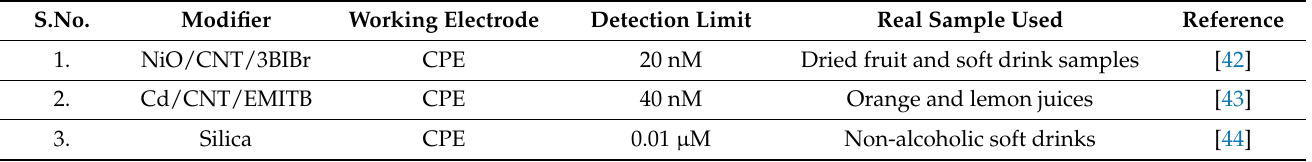
Figure 11. Ball and stick atomic model of Carmosine. In 2017, M. Bijad et al. [42] detected CR at a CPE modified using NiO/CNT with 3-methyl-3-butyl imidazolium bromide (3BIBr) in the presence of TR. They used CV to compare the peak currents of bare and modified electrodes. Modified electrodes showed enhanced peak currents and the electron transfer process was irreversible. The electrode showed a detection limit of 20 nM in the presence of TR. Dried fruit and soft drink samples were employed for the real sample analysis of both the dyes (TR and CR) and gave a recovery >99.25%. In 2018, H. M. Nehzad et al. [43] detected CR at a CPE modified using Cd/CNT& 1-ethyl-3-methylimidazolium tetrafluoroborate (EMITB). They studied the electrochemical behavior of CR at the modified electrode using linear sweep voltammetry (LSV) and found low oxidation current with enhanced peak current. This indicated good electrical conductivity and long-term stability of modified electrodes with a detection limit of 40 nM. The real sample analysis using fruit juices showed a recovery >97% at this electrode. In 2020 the detection of CR was performed by using CPE modified by silica with cetylpyridinium chloride (CPE/SG/CPC), which has high sorption ability compared to azo dye (A. Chebotarev et al. [44]). The authors discussed the electrochemical behavior of CR on the CPE, CPE/SG, and CPE/SG/CPCl, in a detailed manner using SWV (shown in Figure 12) and CV at pH 2. The peak current is higher at CPE/SG/CPCl when compared to other electrodes. The limit of detection for this modified electrode was found to be 0.01 µ M. Their results prove that silica with cetylpyridinium chloride will improve the CR adsorption on the electrode surface. Table 7 shows the detection limit of Carmoisine at the different modified carbon paste electrodes. Table 7. Table showing Carmoisine detection using carbon paste electrodes with different modifiers along with their detection